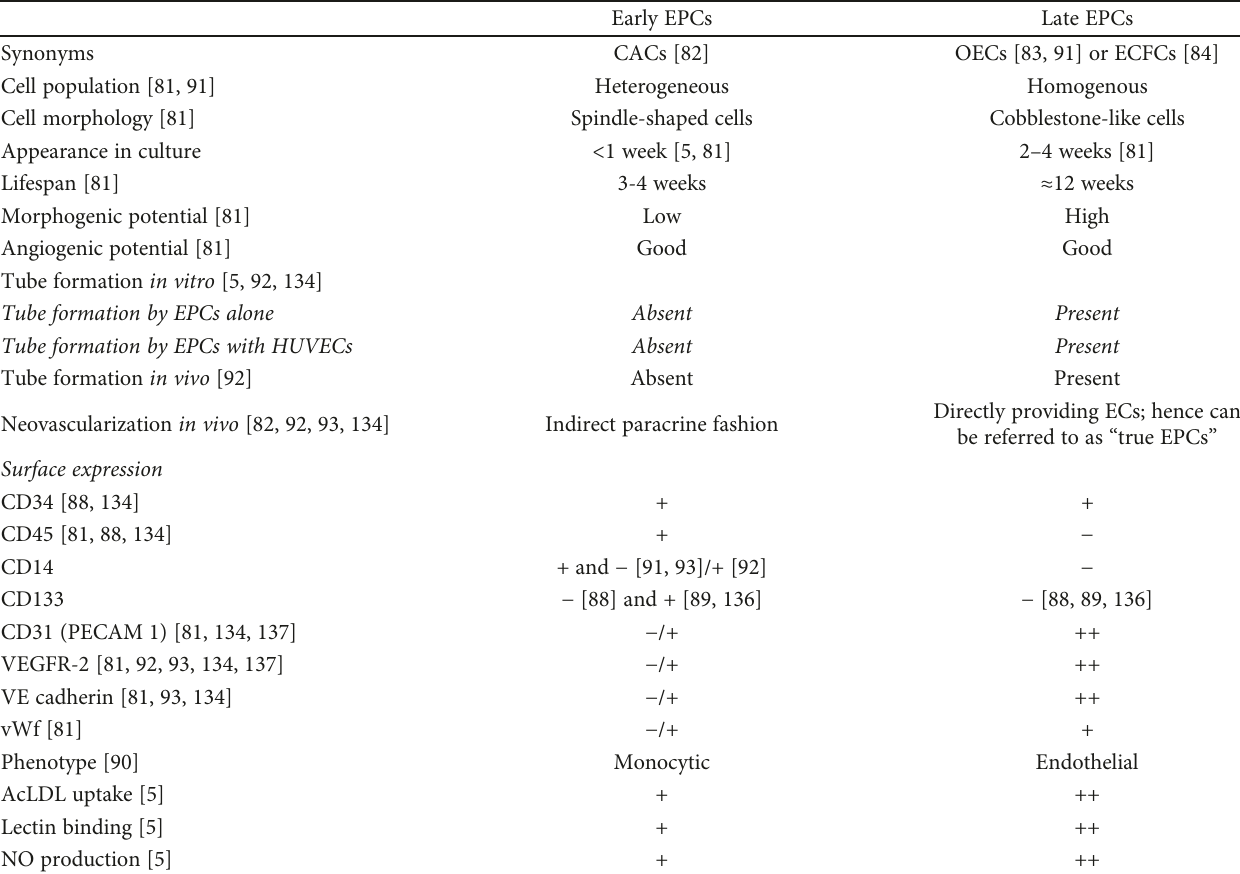
Table 1: Di ff erences between eEPCs and